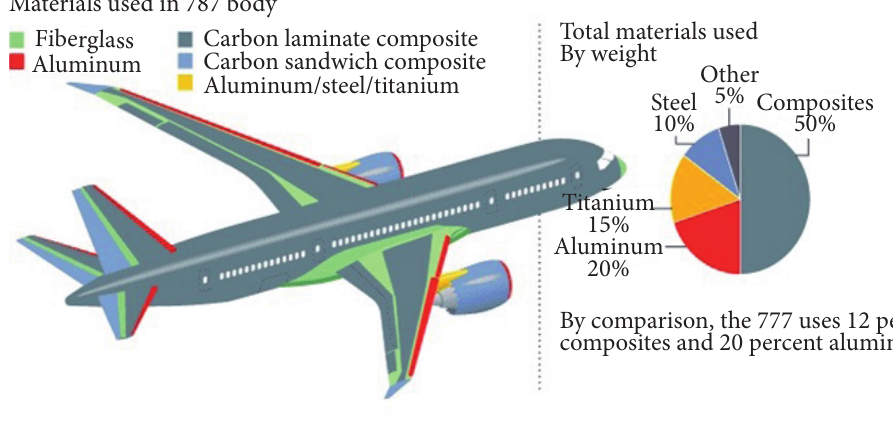
Materials used in 787 body